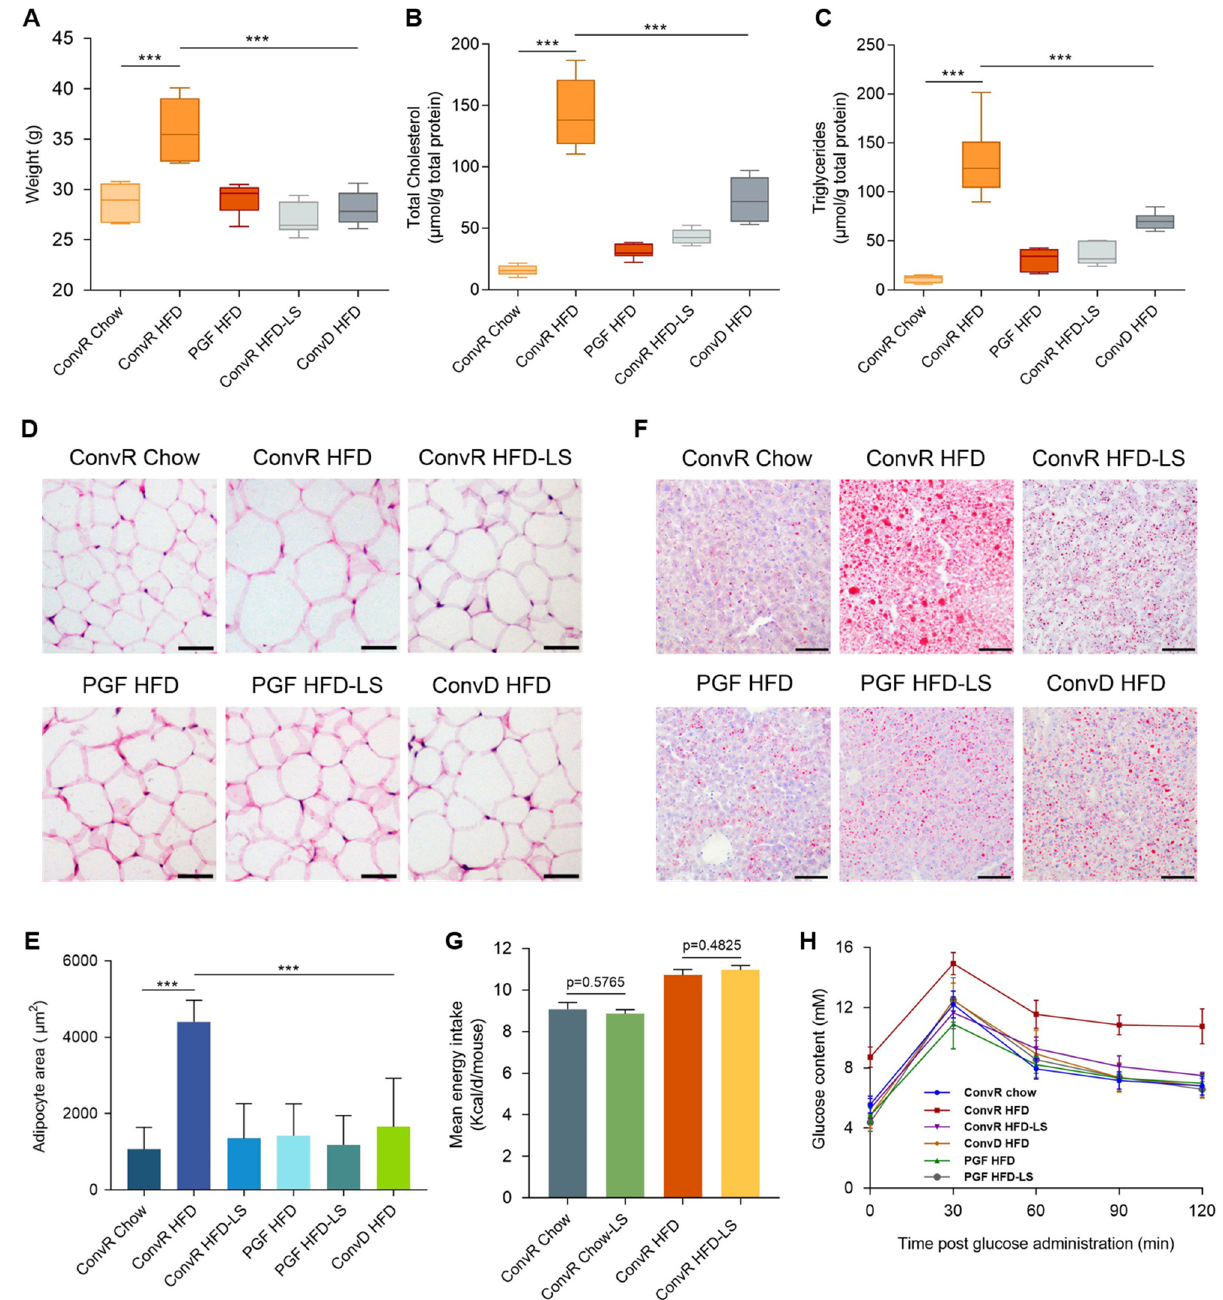
Figure 1. Body weight and lipid lowering effects of LS. Weights ( A ), hepatic total cholesterol ( B ), hepatic triglycerides ( C ), epididymal adipocyte size ( D , E ), and liver lipid content ( F ) of Chow- and HFD-fed ConvR, PGF, or ConvD mice treated with water or LS at the time of sacrifice. In ( D ), adipocyte size was estimated using the Image J software. Scale bar, 50 µ m. In ( F ), liver lipid content was assessed using oil red O staining. Scale bar, 100 μ m. ( G ) , the mean energy intake of normal diet or HFD fed mice after tea intervention. Energy intake was determined based on calorie intake from consumed food. ( H ), the oral glucose tolerance of mice with different trentments. Mice fasted overnight were given glucose by oral gavage (2 mg/kg BW). Blood glucose was determined at 0, 15, 30, 60, and 120 min post glucose administration. Data were expressed as mean ± SEM. Differences of data in mice ( A – C , E , F ) were analyzed using one-way ANOVA analysis *** p < 0.001; error bars represent SEM; n = 6 mice per condition. The mean energy intake ( G ) was analyzed using unpaired two-tailed Student’s t -test.